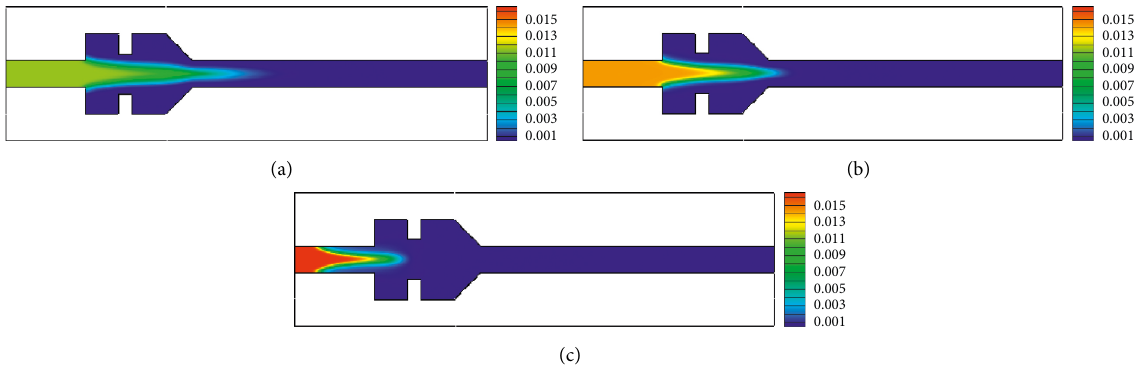
Figure 13: H 2 distribution of the improved microcombustor at the following equivalence ratios: (a) Φ